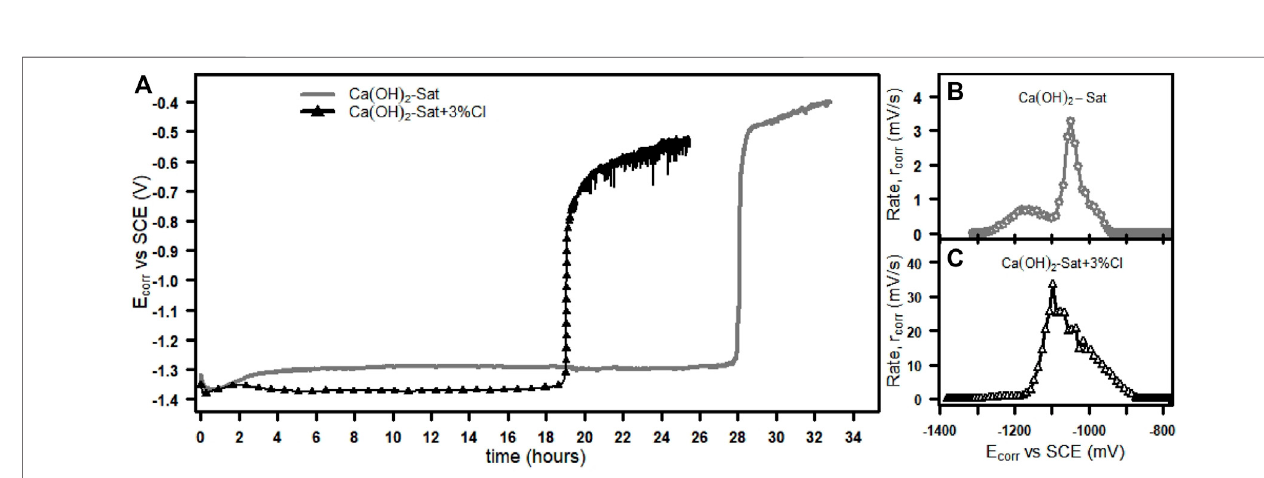
FIGURE 3 | E corr evolution with time of (A) zinc plates in saturated Ca(OH) 2 solutions with and without chlorides. (B) The rate of change of potential, r corr vs. E corr , without chlorides and (C) r corr vs. E corr with chlorides.